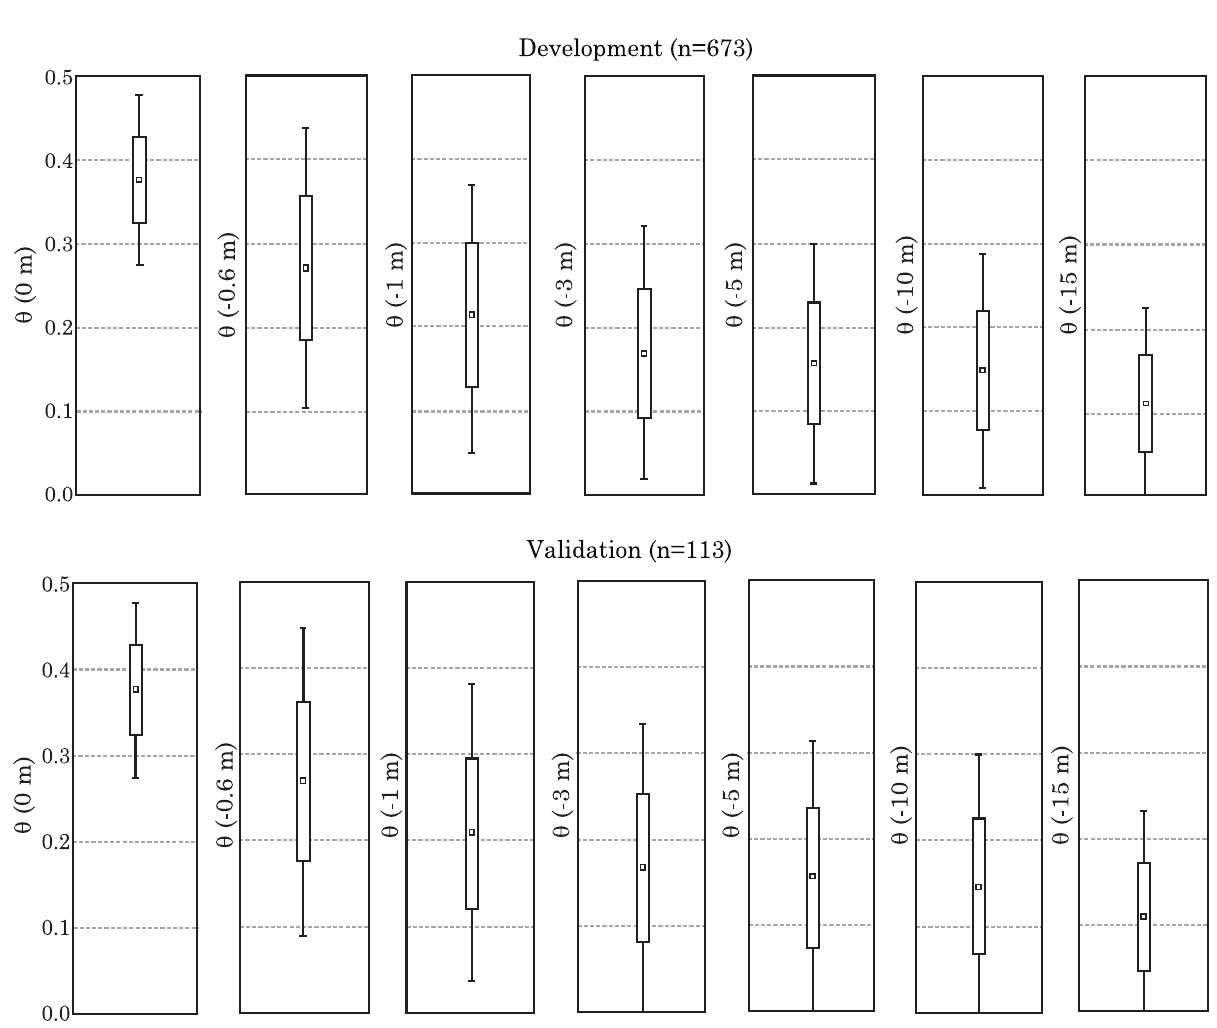
Figure 5. Box-plots of water content at specific pressure heads for the development and validation subsets. Bar minimum and maximum represent the smallest and largest observation respectively, box minimum and maximum represent the lower and upper water content sample quartile, respectively, and the dot represents the median